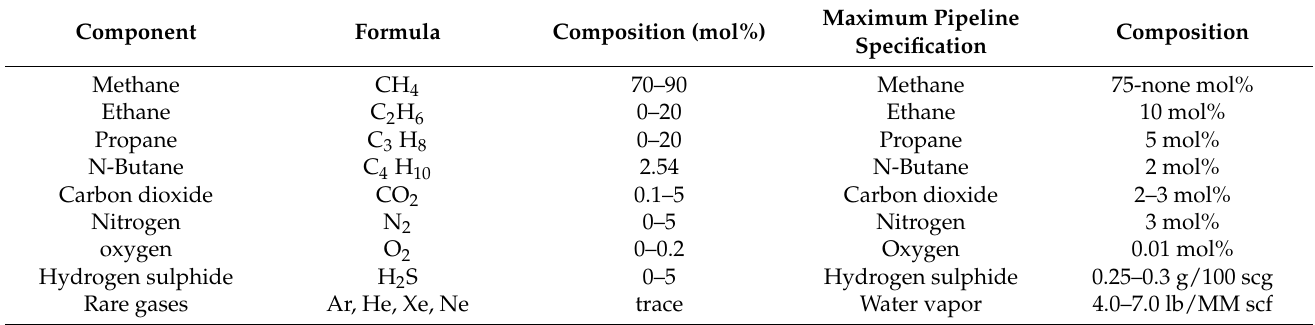
Table 1. Composition of raw natural gas and pipeline specifications